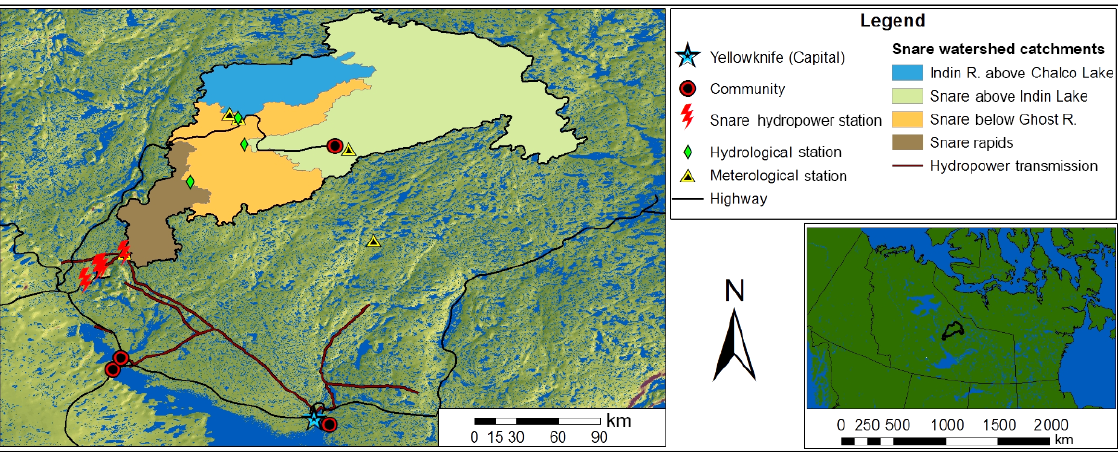
Figure 1. Snare Watershed location in Northwest Territories,